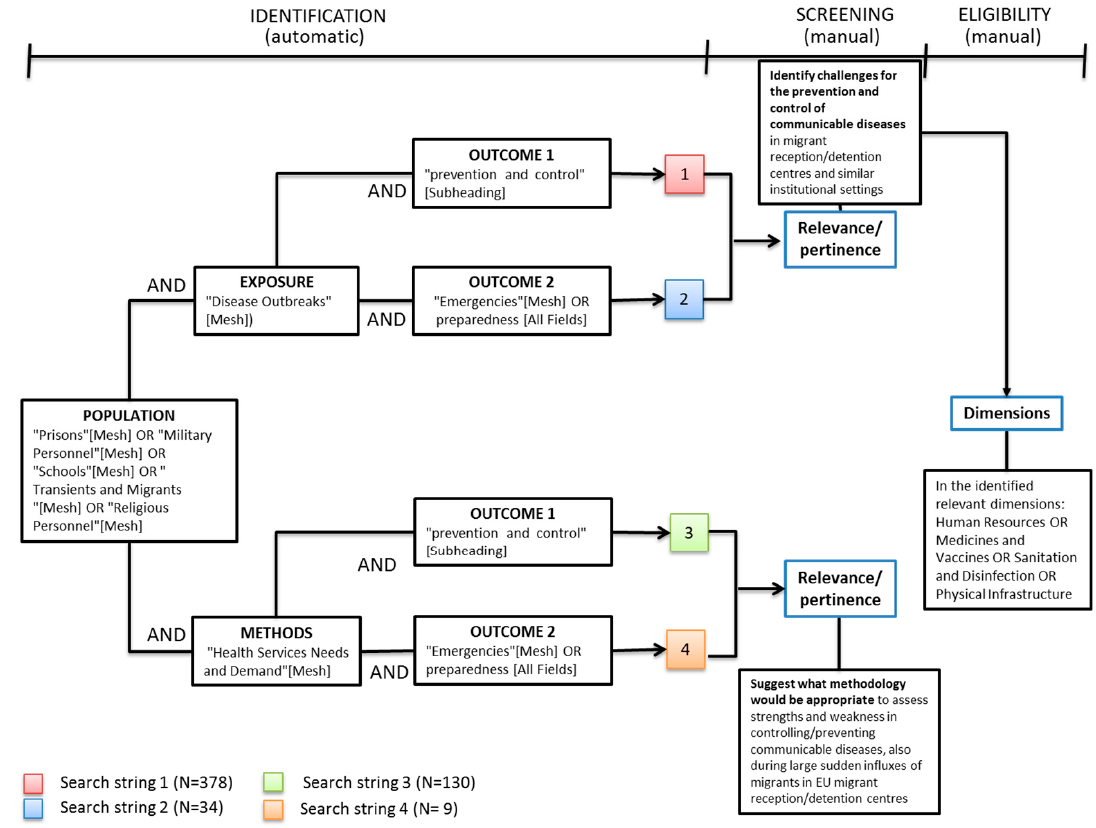
Figure 1. Scientific literature search strategy diagram. EU: European Union.